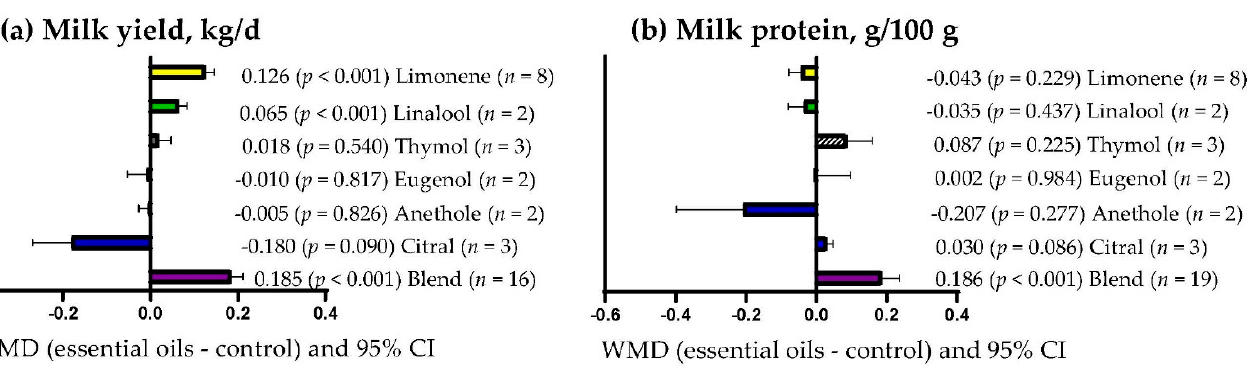
Figure 6. Subgroup analysis (subgroup = primary bioactive compound) of the effect of essential oils supplementation to small ruminants’ diets on their milk yield and composition; WMD = weighted mean differences between essential oil treatments and control.